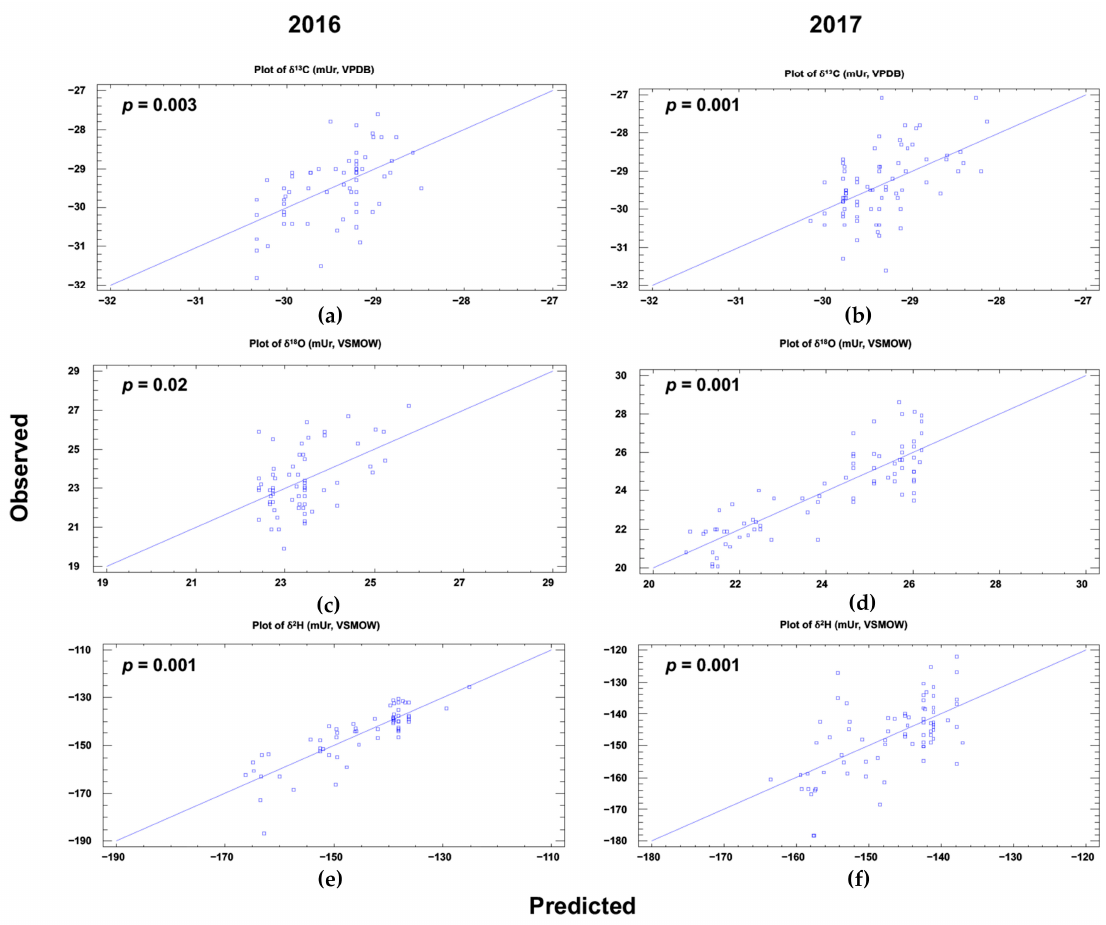
Figure 4. Observed vs. predicted values for carbon, oxygen and hydrogen isotopic composition in two harvest years (2016 and 2017) calculated by multiple linear regression (MLR) using geoclimatic parameters of VOO producer areas as predictors. ( a , b ) plots of δ 13 C from 2016 and 2017; ( c , d ) plots of δ 18 O from 2016 and 2017; ( e , f ) plots of δ 2 H from 2016 and